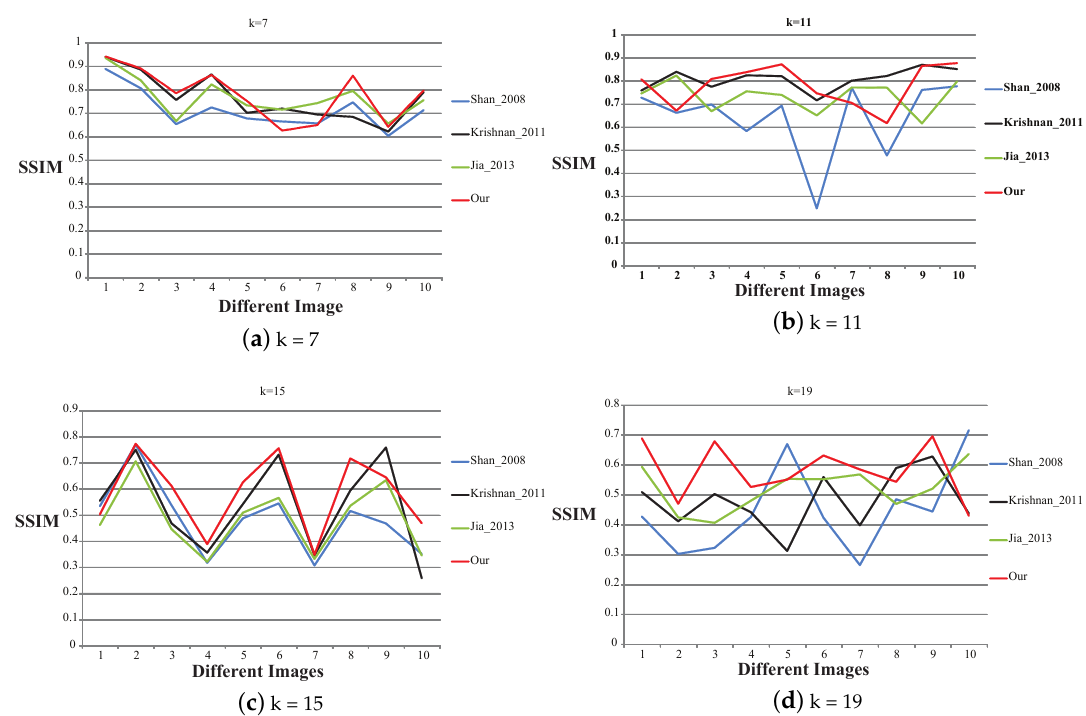
Figure 10. SSIM values of various methods with different kernel size: ( a ) k = 7; ( b ) k = 9; ( c ) k = 15; and ( d ) k =